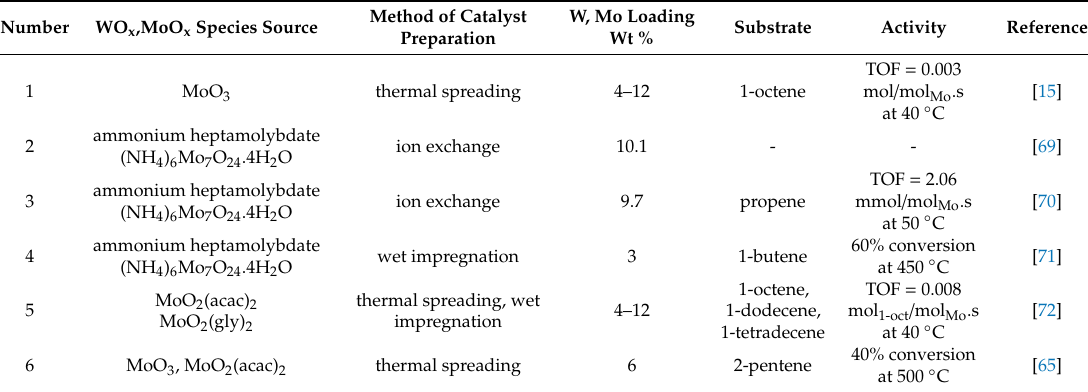
Table 2. Survey of Mo and W oxide catalysts supported on